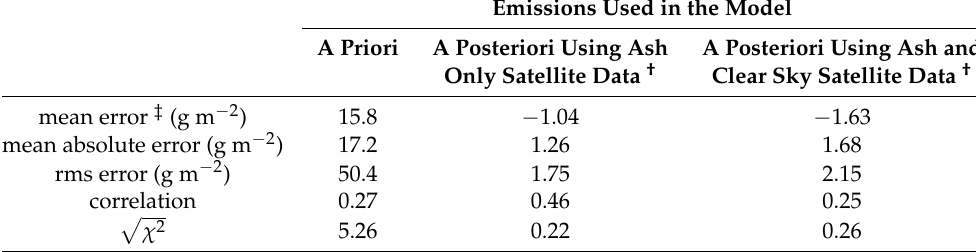
Table 3. Statistical comparison between modelled column loads and satellite ash retrievals for the Grímsvötn 2011 eruption at the locations of the 3267 ash-only retrievals * made up to 31 May 2011 00:00